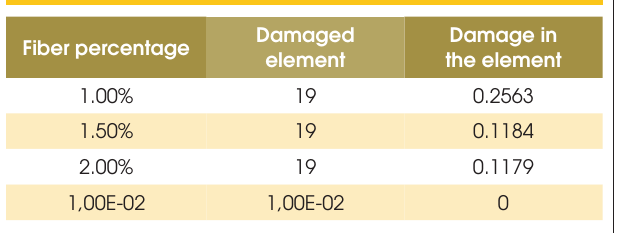
Table 6 – Damage analyses for tension in function of fiber percentage